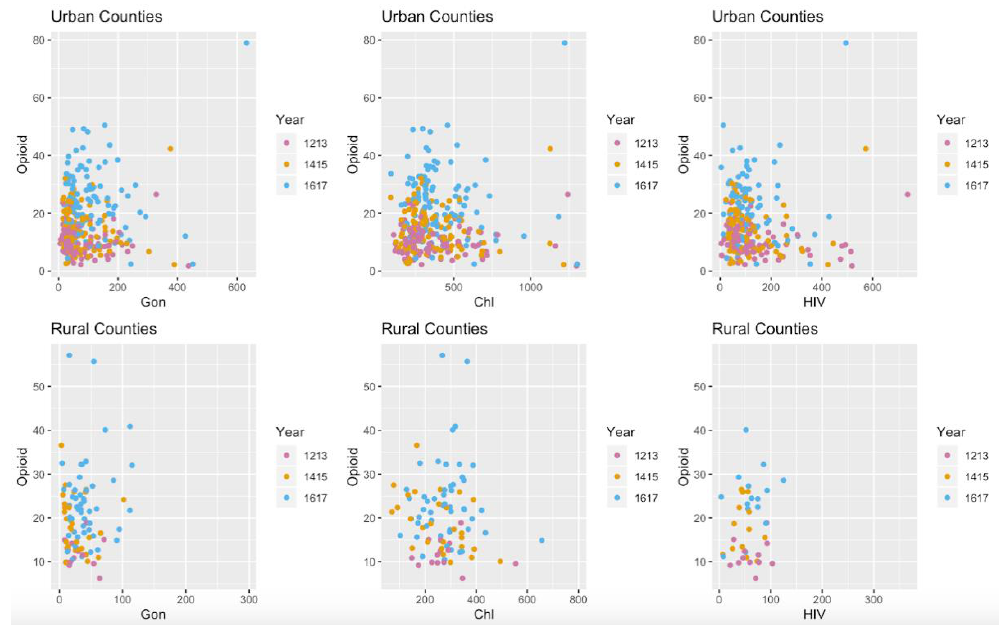
Figure A7. The distributions of county values of each of the response variables used in the model separated by year group. Red represents 2012–2013, orange represents 2014–2015, and blue represents 2016–2017.